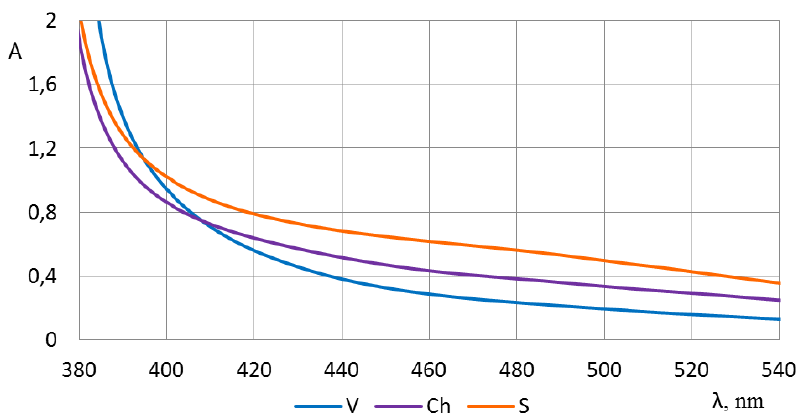
Figure 4. The absorption spectra of Viorica (V), Chardonnay (Ch) and Sauvignon (S) wine samples in the visible region, (undiluted wine, cuvettes path length 5 cm).